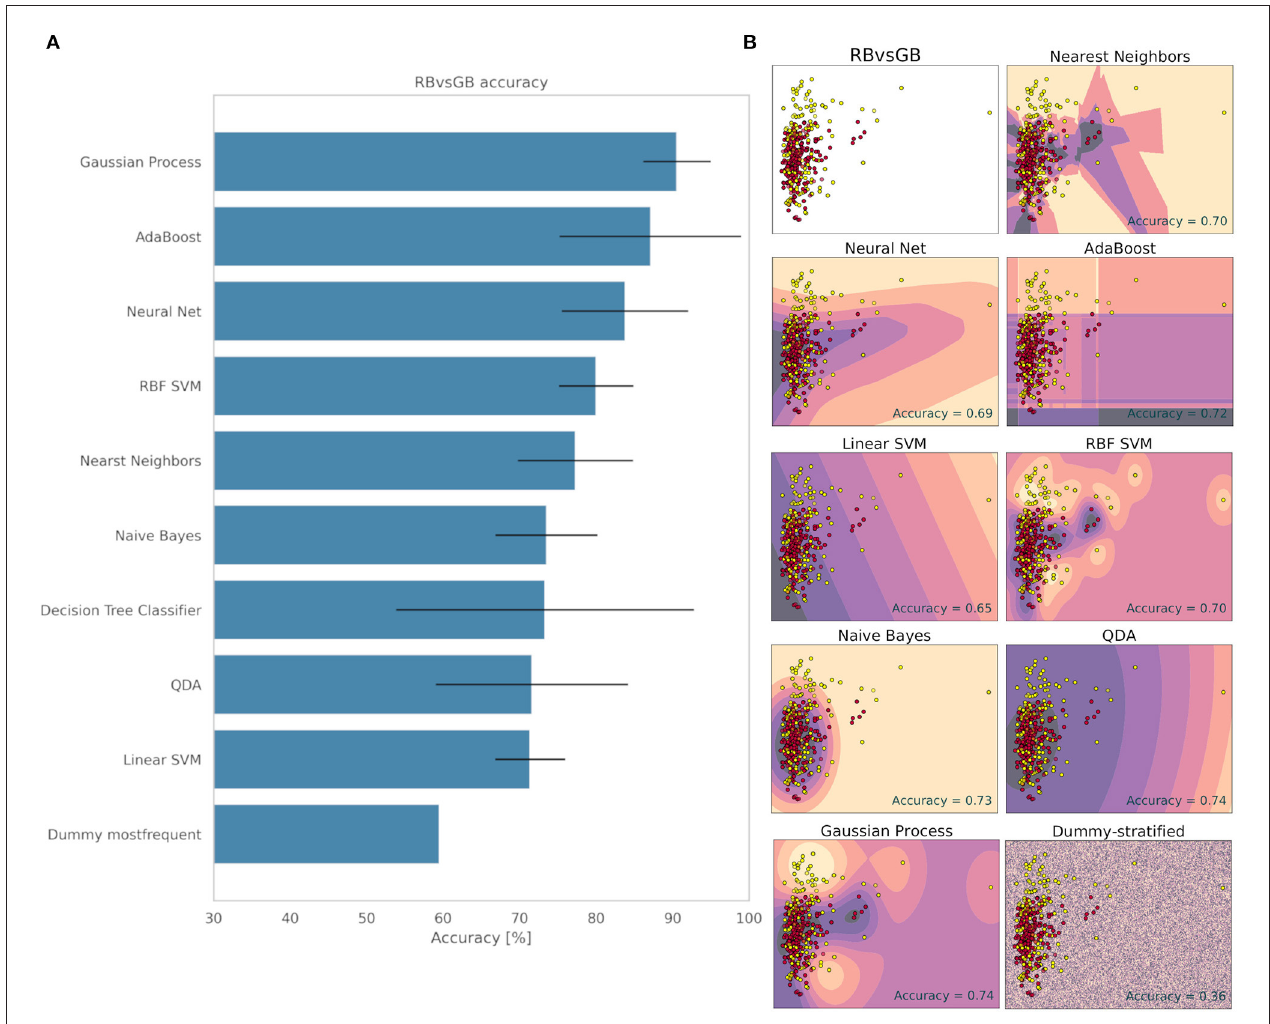
FIGURE 5 | Accuracy (%) and standard deviation (A) of the Machine Learning models used to classify RB and GB groups. Scatter plots (B) showing a sample space plan used in ML training for the RB × GB distribution. Red dots: RB; Light yellow spots: GB. The regions are the demarcations made by ML to indicate levels of certainty of classification. The darker it is, the more certain it belongs to the RB group. The clearer the more certainty of belonging to the GB group. The subtitle of each graph indicates the method used and in the lower right quadrant is the accuracy